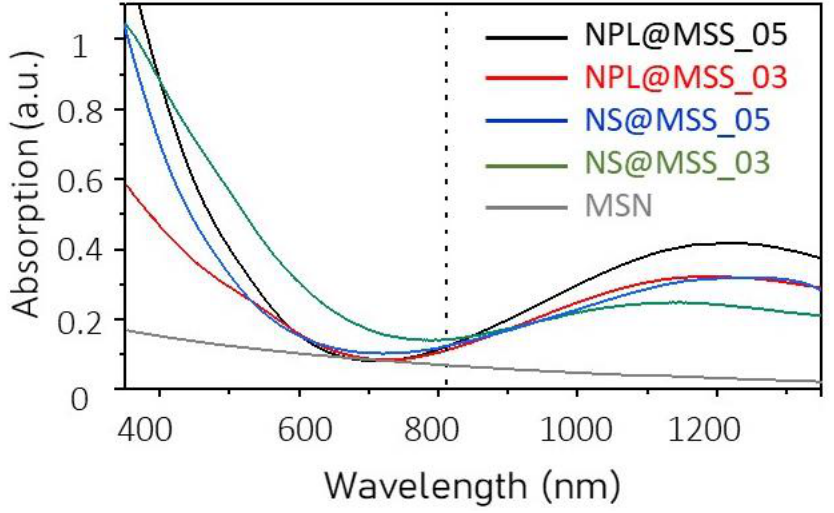
Figure 4. UV-Vis-NIR absorbance spectrum of each nanostructure along with the absorption spectrum of MSN (grey line). Dashed line at 808 nm, which is the wavelength of the CW laser light used for photothermal experiments.